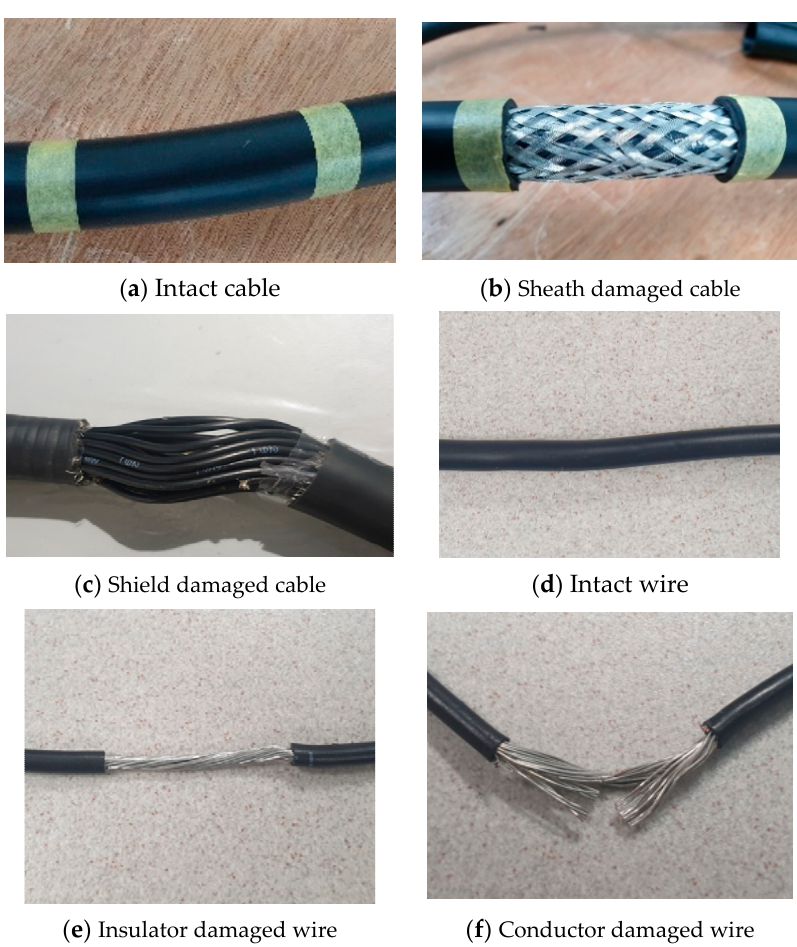
Figure 2. ( a ) A normal cable with intact sheath. ( b ) A faulty cable without sheath (the braided shield is visible). ( c ) A faulty cable without shield (the wires are visible). ( d ) A normal wire inside the cable. ( e ) A faulty wire without an insulator (the conductor is visible). ( f ) A faulty wire with damaged conductor (some strands are cut).